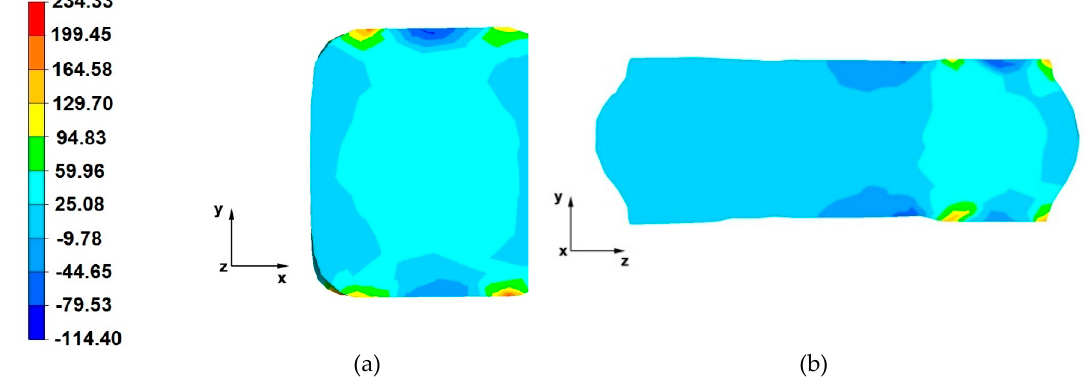
Figure 10. Distribution of the hydrostatic pressure of the AZ 91 alloy forging, deformed in the sixth pass with 40% reduction in flat anvils after slanting by 90°: ( a ) on the cross-section, ( b ) on the longitudinal section.